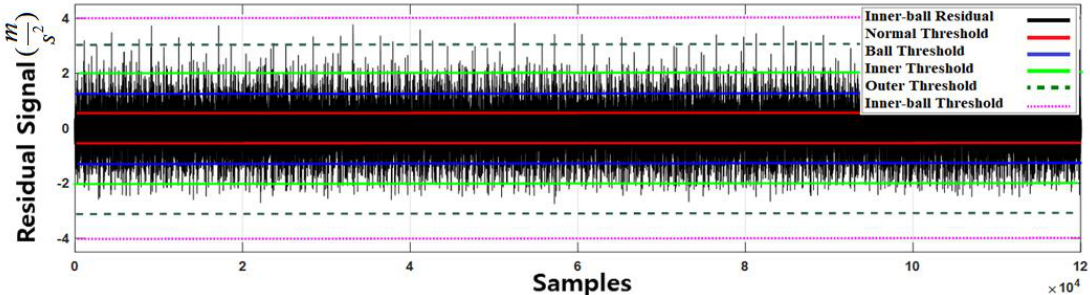
Figure 15. Outer residual signal, normal threshold, ball threshold, inner threshold, and outer threshold signal for the outer faulty condition with a crack width of 6 mm.